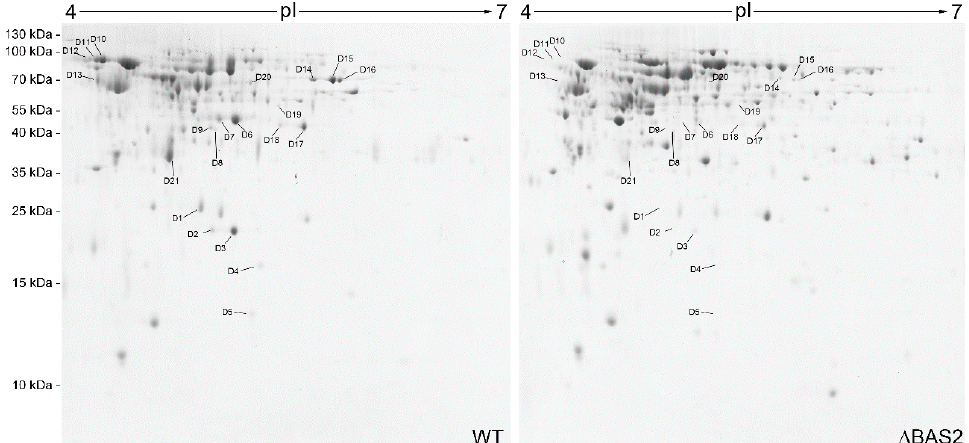
Figure 5. Two-dimensional patterns of extracellular proteomes of WT and Δ BAS2. Arrows indicate protein spots that were downregulated in abundance more than 1.5-fold between WT and Δ BAS2. Numbering of protein spots corresponds to numbering in Table 1.